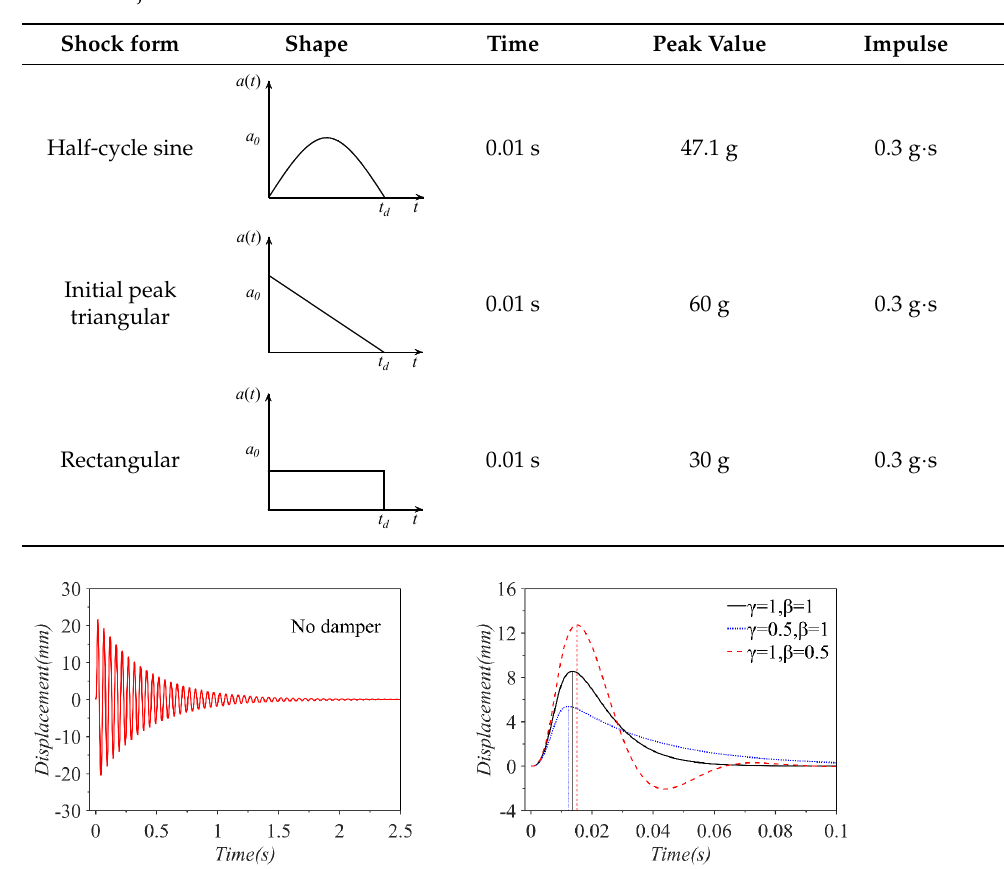
Figure 5. Time − histories for displacement, velocity, acceleration, and energy of the SDOF system subjected to half-cycle sine shock: ( a ) Without damper; ( b ) With an ECD. Table 2. Adjusted acceleration loads.